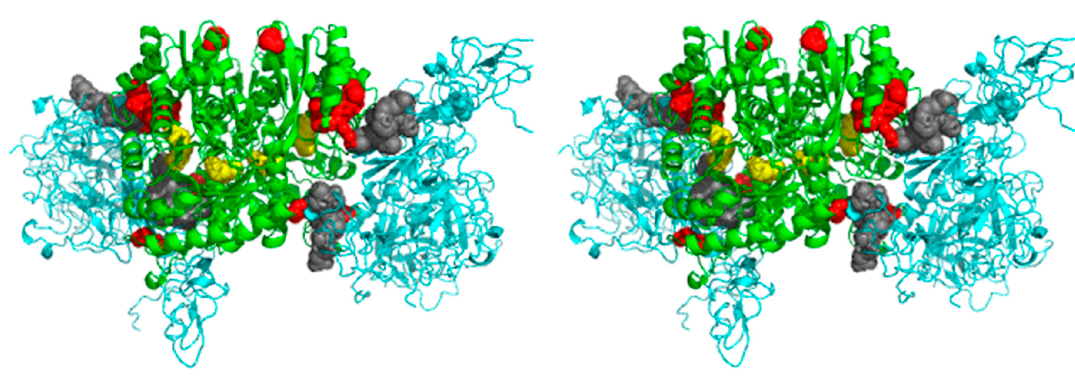
Figure 7. Proposed model of the C. albicans enolase interaction with human HPG. The docking was performed for the C. albicans enolase dimeric structure (template PDB ID: 1EBH [58]) and HPG structure (PDB ID: 4DUU [59]). The enolase dimer is indicated in green and HPG is denoted in blue. The enolase and HPG peptides identified in the chemical mapping experiments are marked in red and gray, respectively. The active site residues of the catalytic center of the enolase are highlighted in yellow. The 3D molecular model is presented in a wall-eyed stereo view. An additional file Enolase_HPG.mpg with the PyMOL-generated video presentation of this model is attached to the article together with the Supplementary Materials (Video S4).